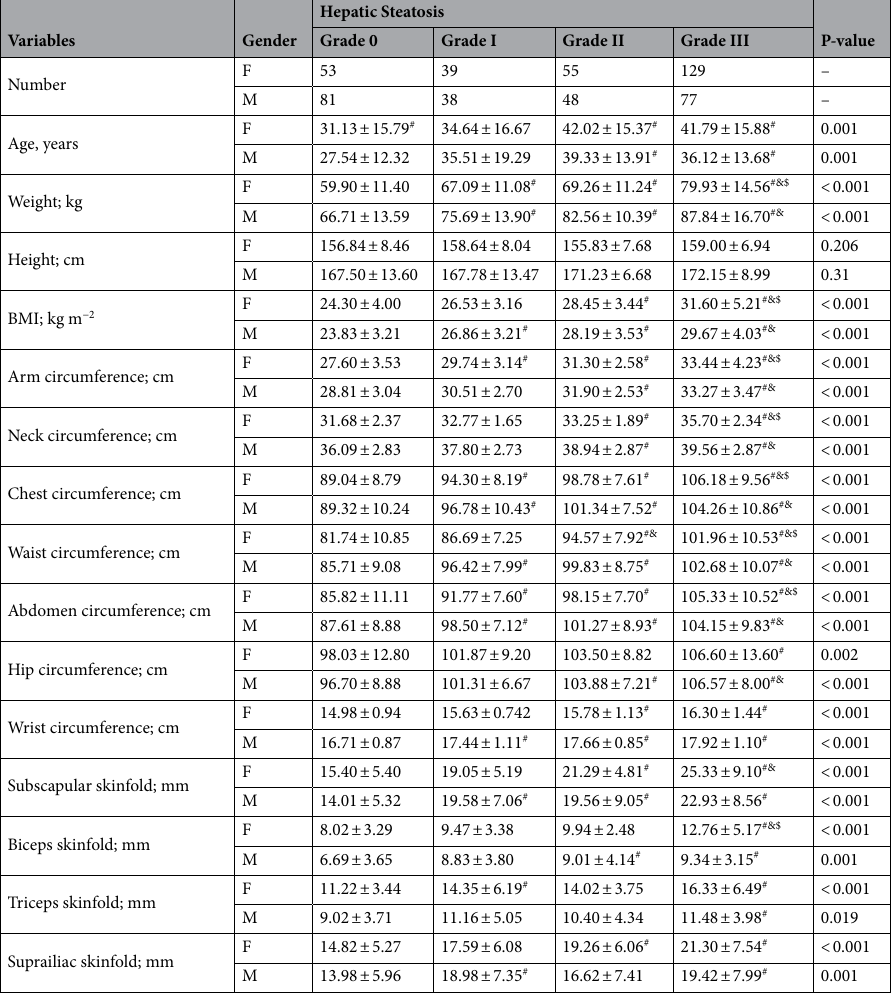
Table 2. A comparison of the anthropometric variables across different stage of the hepatic steatosis in male and female participants. Abbreviation. BMI: body mass index. Data are presented as means ± standard deviations. P values were obtained from analysis of variance (ANOVA), followed by Tukey’s post hoc test. # Significant difference (P < 0.05) compared with grade 0; & Significant difference (P < 0.05) compared with grade 1; $ Significant difference (P < 0.05) compared with grade